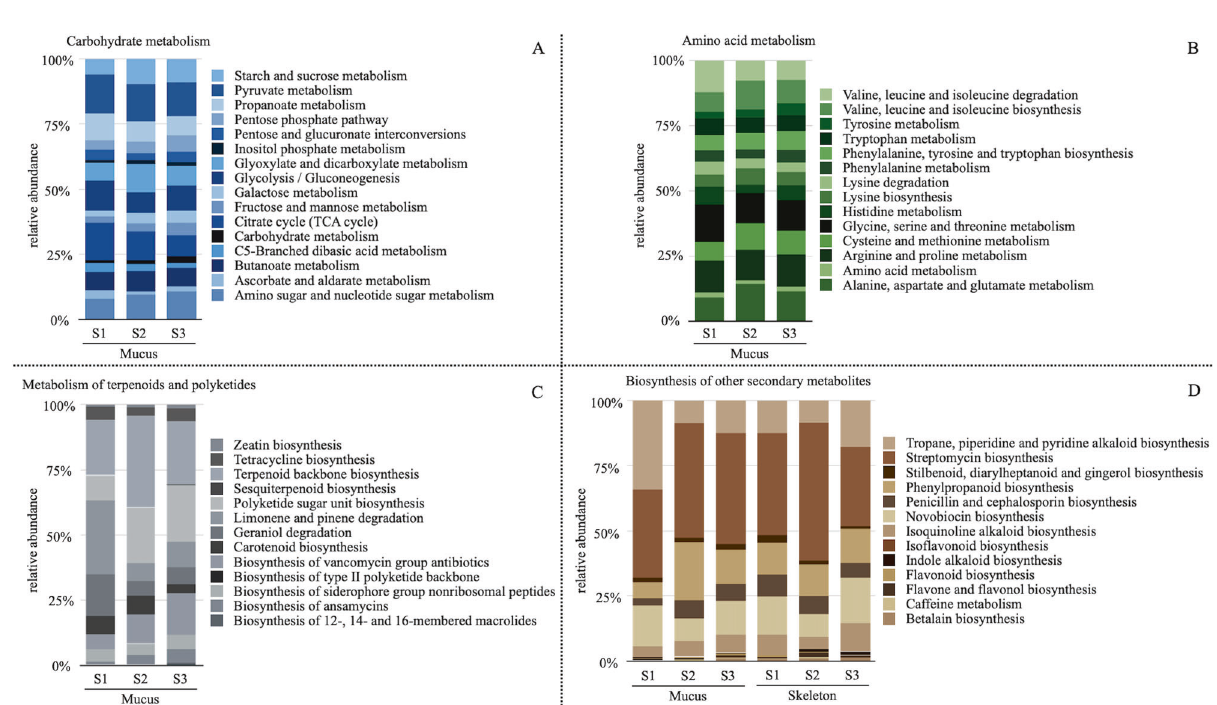
Fig. 3 Distribution of functional pathways in selected KEGG networks in B. europaea metagenomes. Bar plots representing average relative abundance of KEGG pathways expressed as percentages of reads assigned to speci fi c pathways with respect to the total number of reads assigned to the networks “ Carbohydrate metabolism ” (KEGG classi fi cation 1.1) ( A ), “ Amino acids metabolism ” (KEGG classi fi cation 1.5) ( B ), “ Metabolism of terpenoids and polyketides ” (KEGG classi fi cation 1.9) ( C ), and “ Biosynthesis of other secondary metabolites ” (KEGG classi fi cation 1.10) ( D ). All bar plots refer to the metagenome obtained by mucus samples of B. europaea collected at Site 1 (S1), Site 2 (S2) and Site 3 (S3), with the exception of the network “ Biosynthesis of other secondary metabolites ” ( D ) for which data referring to skeleton samples are also plotted. Color legend is provided for each